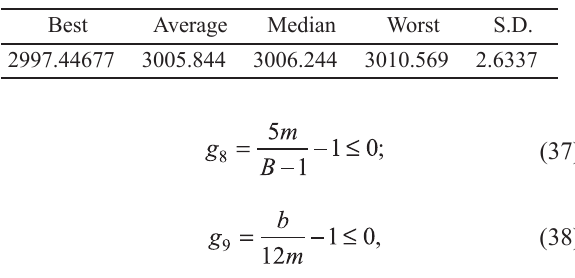
Table 5. Statistical results of the speed reducer design example using KH